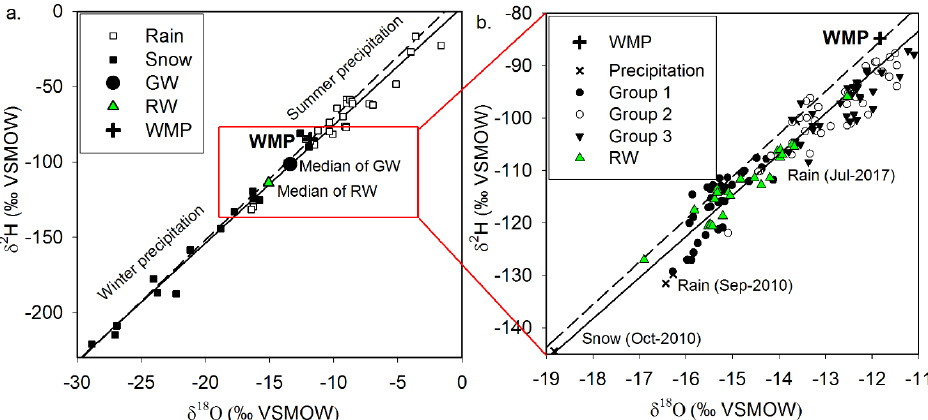
Figure 8. δ 18 O and δ 2 H values of water in the study area: ( a ) precipitation from 1990 to 2001 (data obtained from [35]) and ( b ) water sample groups of this study from 2010 to 2017. WMP indicates the weighted median precipitation of UB, and the Global Meteoric Water line (GMWL) and Local Meteoric Water line (LMWL) are presented as solid and dotted lines, respectively. GW and RW denote groundwater and river water, respectively.